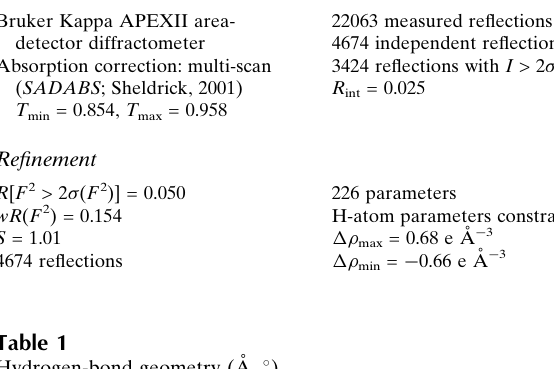
Hydrogen-bond geometry (A˚ , (cid:1)